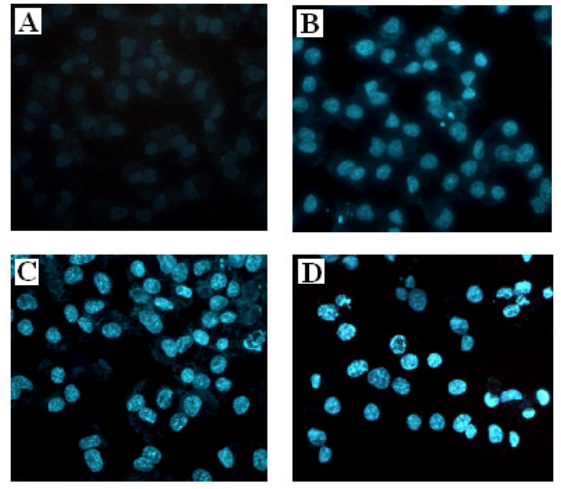
Figure 4. Flow cytometric analysis of A549 cells apoptosis following exposed to SBT-A. A549 cell lines were treated with low to high concentrations of SBT-A (20, 40, and 80 μ g/mL) for 48 h. The flow cytometry assay was performed to determine the apoptosis rate by Annexin-V/PI double-staining. ( A – D ) represented the groups of control, 20, 40, and 80, ( E ) is the statistical chart of Figure 4 A–D; the data are represented as mean ± S.D ( n = 4). * p < 0.05 and ** p < 0.01 vs .